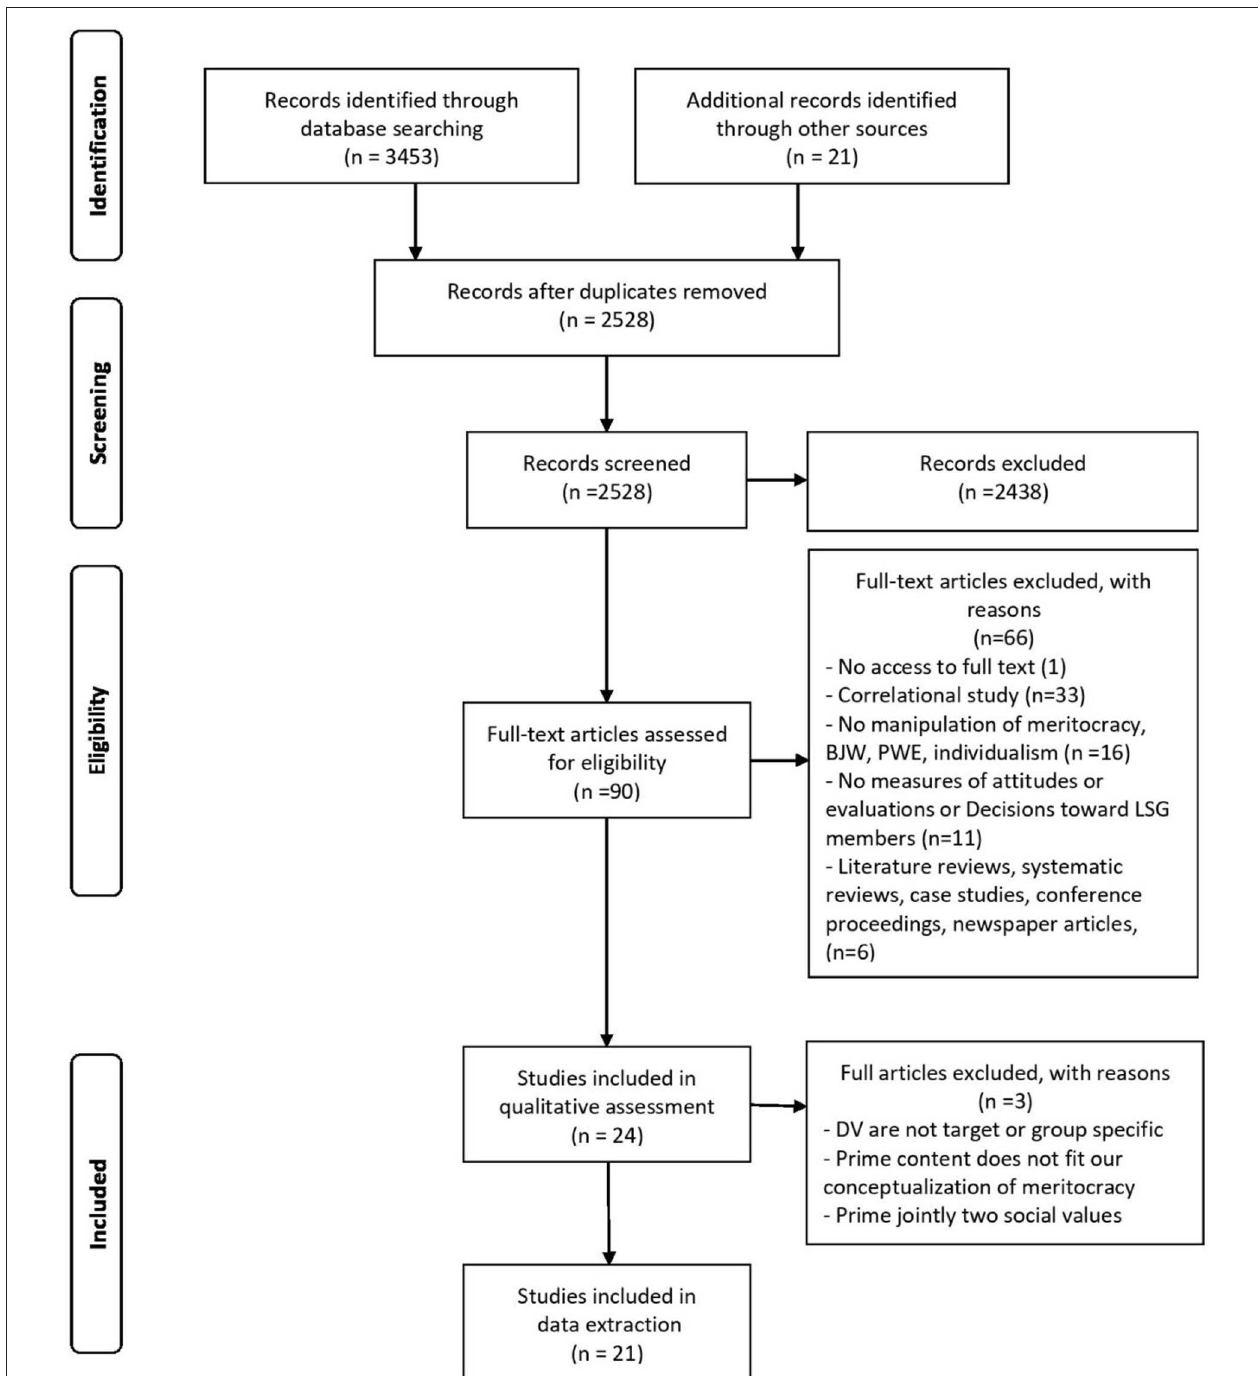
FIGURE 1 | PRISMA flow diagram of search results (Moher et al.,